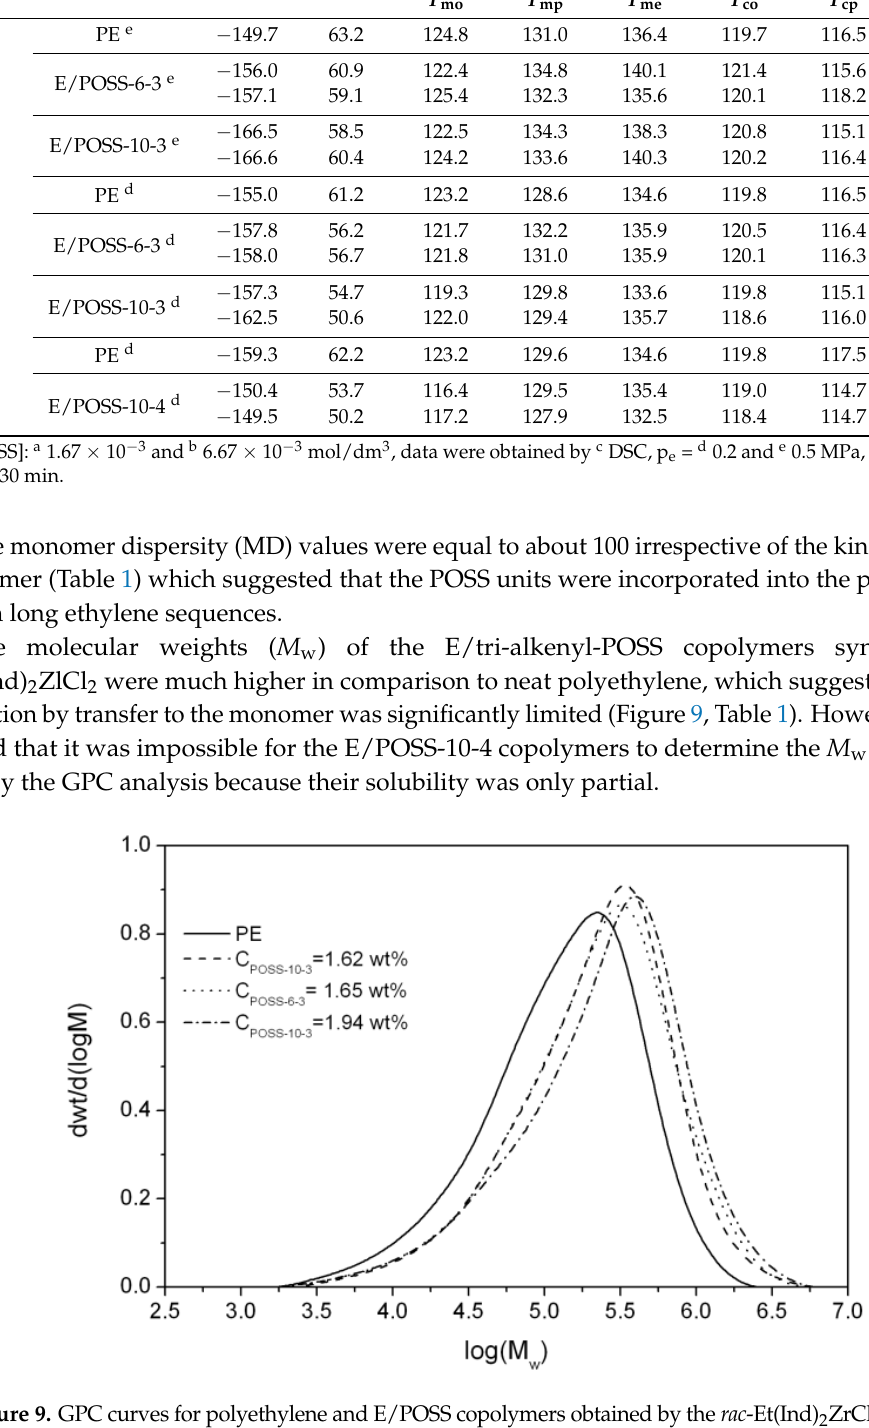
Figure 9. GPC curves for polyethylene and E/POSS copolymers obtained by the rac -Et(Ind) 2 ZrCl 2 catalyst.